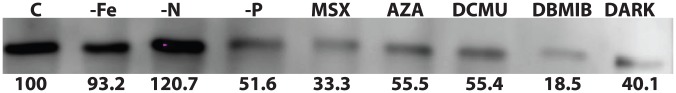
ICDH Western blotting of cell extracts from Prochlorococcus sp. strain PCC 9511 cultures subjected to different conditions.Cultures were subjected to the indicated conditions for 24(except in the case of iron starvation, which were starved for 8 h). C, control; -Fe, iron starvation; -N, nitrogen starvation; -P, phosphorus starvation; MSX, 100 µM methionine sulfoximine; AZA, 100 µM azaserine. The quantification of bands is shown below the picture, assigning an arbitrary value of 100 to the control conditions.